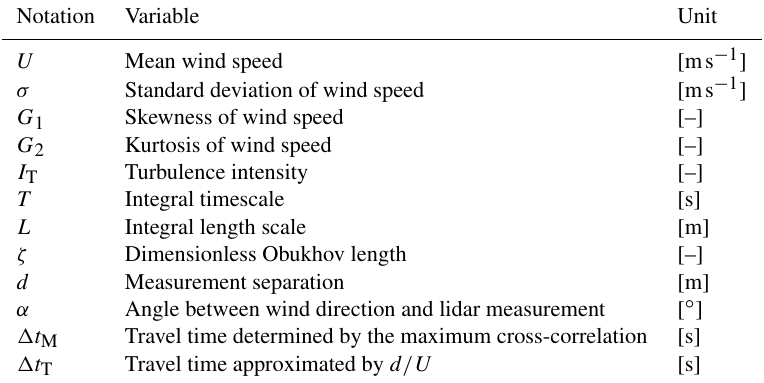
Table 1. Notations of potential